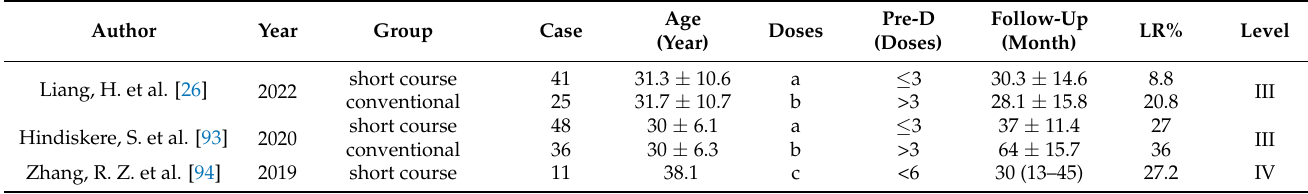
Table 3. Summary of short-term PDAT for surgically